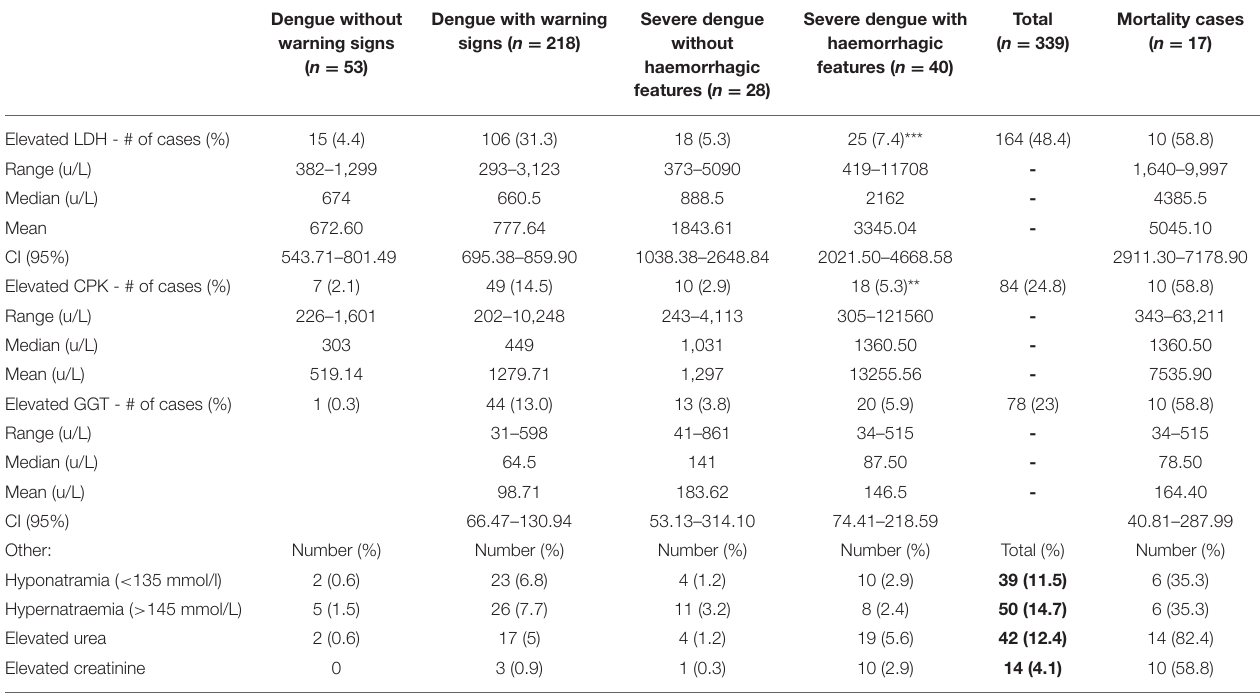
TABLE 5C | Biochemical investigations in pediatric patients hospitalized with suspected and confirmed dengue in the 2018–2019